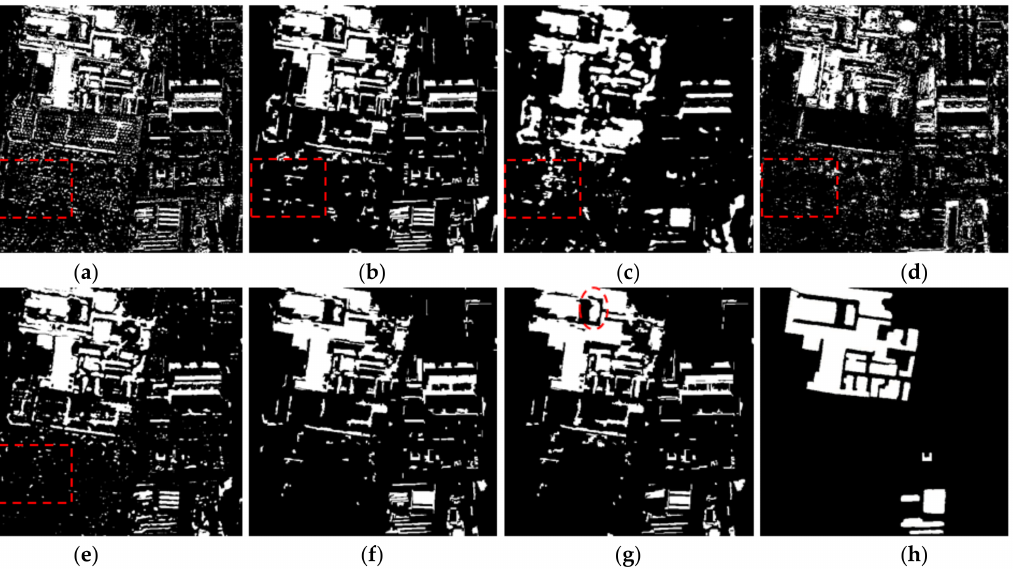
Figure 13. Binary change maps of B&T sample 1 generated by different methods: ( a ) CVA; ( b )